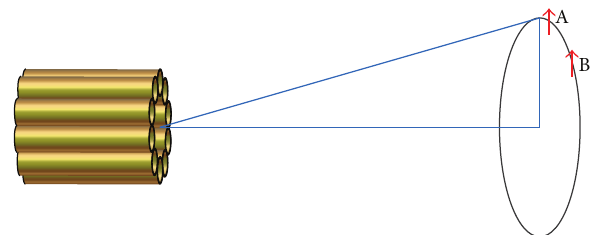
Figure 16: Schematic of the OAM